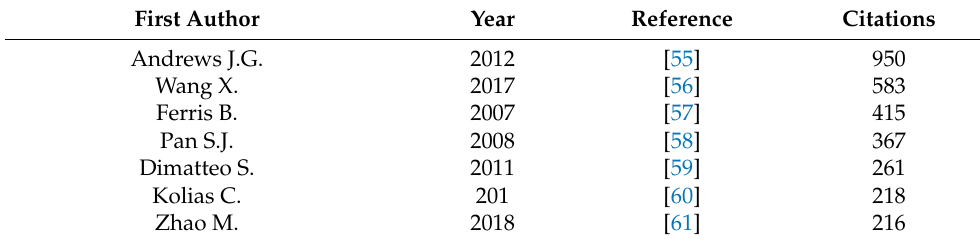
Table 1. List of the most cited papers.